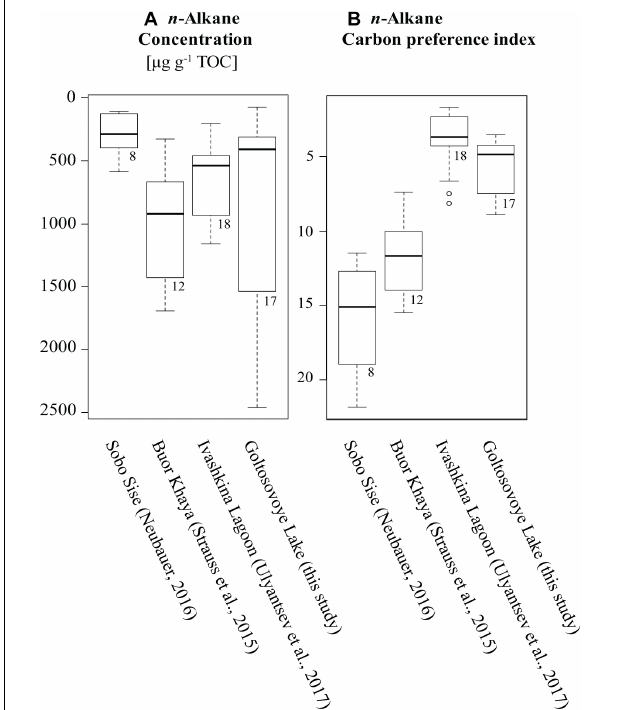
FIGURE 9 | Box-whisker plots of biomarker parameters from Siberian Yedoma studies. (A) n -Alkane concentration and (B) n -alkane carbon preference index. Box-whisker plots according to Tukey with outliers outside of 1.5 IQR. Numbers denote sample